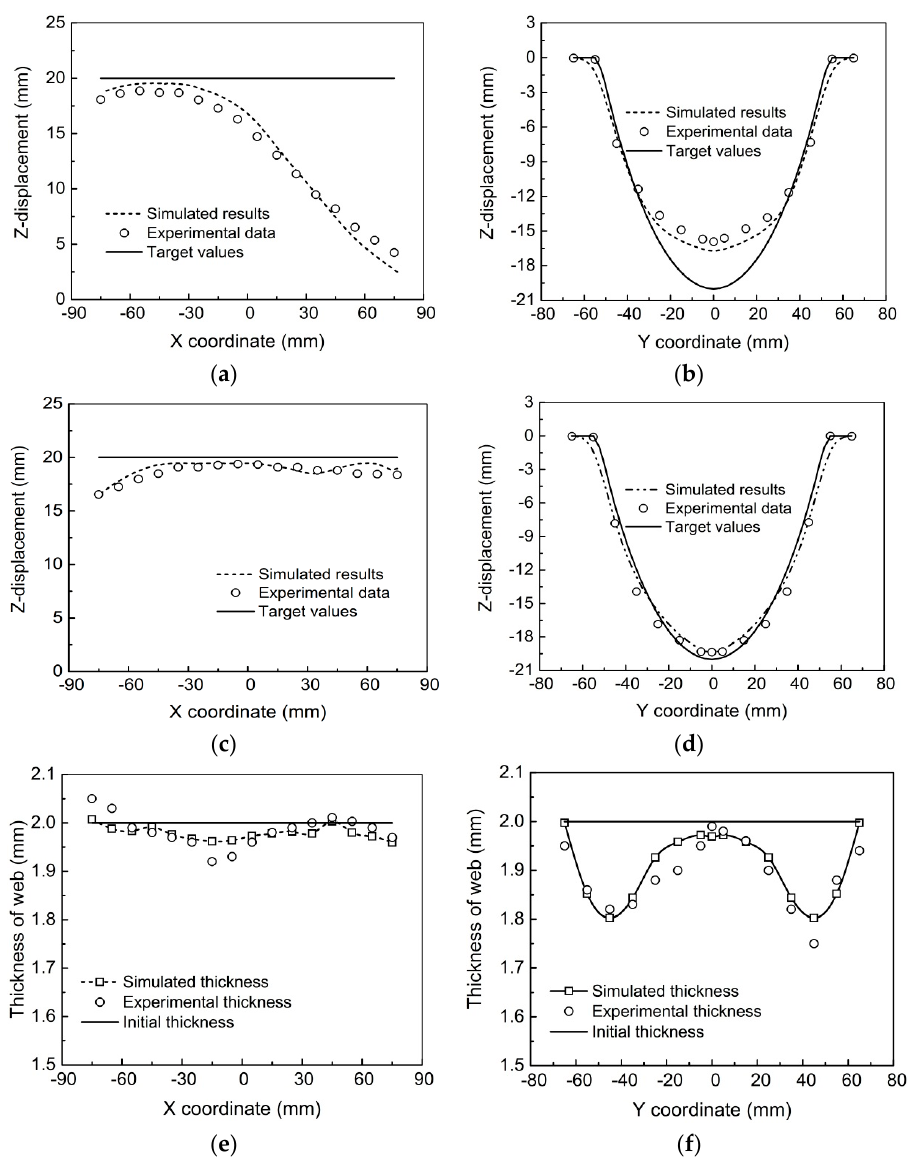
Figure 4. Comparison between experimental and simulated results: ( a , b ) Z -displacement in position A along X and Y path; ( c , d ) Z -displacement in position B along X and Y path; ( e,f ) web thickness along X and ( f ) Y path.